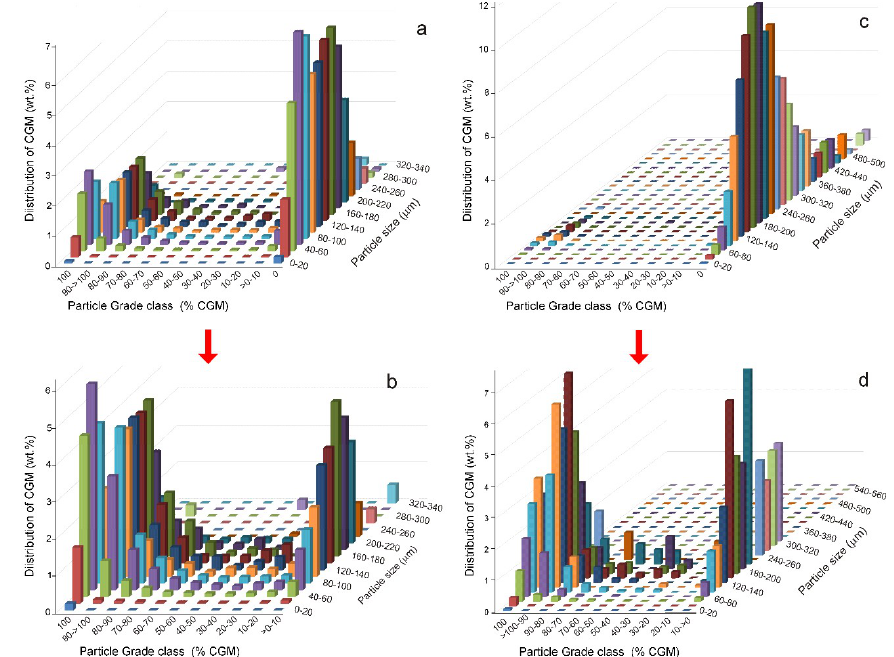
Figure 14. Distribution of CGM in the concentrated materials according to particle size and CGM grade classes. ( a ) Leucogranite, taking all of the particles into account; ( b ) detail where the zero grade particles were not considered; ( c ) tailings taking all the particles into account; and ( d ) detail where the zero grade particles were not considered.